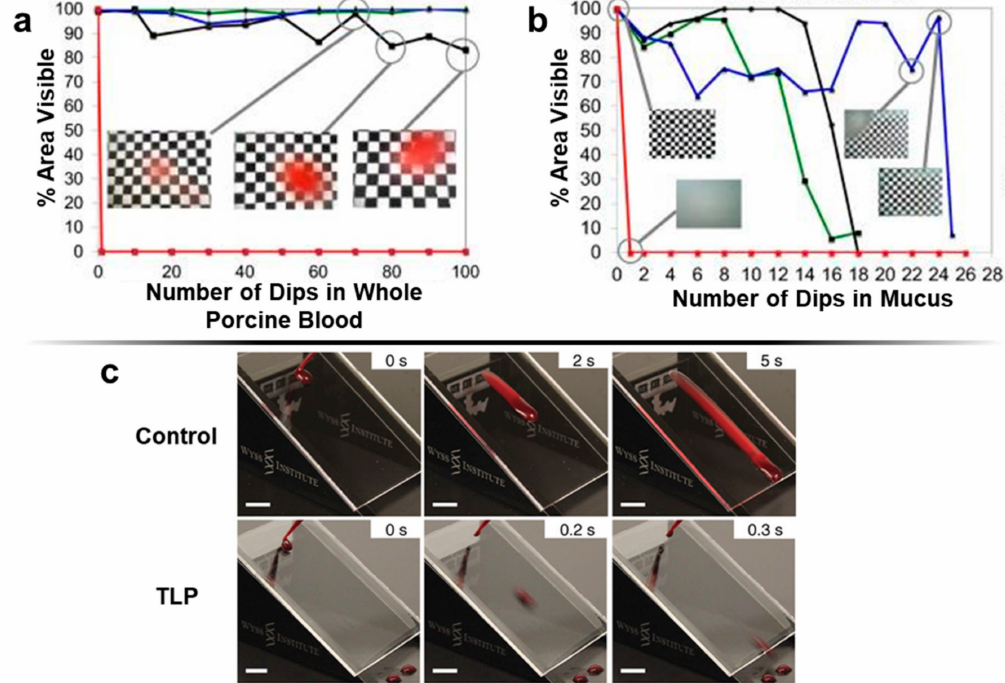
Figure 3. Emerging anti-fouling methods and materials: SLIPS (Slippery Liquid-Infused Porous Surfaces). ( a , b ) Evolution of the reduction in the visible area of an endoscope surface coated by SLIPS as a function of the number of dips. Silicone oil of low viscosity (10 cSt) was used as the lubricating liquid. Red corresponds to an uncoated endoscope, which fails immediately after a single dip. Green, blue, and black correspond to three replicates of SLIPS coated endoscopes; ( a ) endoscope dipped in whole porcine blood. Inset images show the visibility of the field of view at 70, 08, and 100 dips for the poorest performing sample; ( b ) endoscope dipped in mucus. Insets show the visibility of a coated endoscope after repeated dips compared to an untreated endoscope (reproduced, with permission, from [37]). ( c ) Comparison of the repellency of a tethered-liquid perfluorocarbon (TLP) treated surface to an untreated surface (reproduced, with permission, from